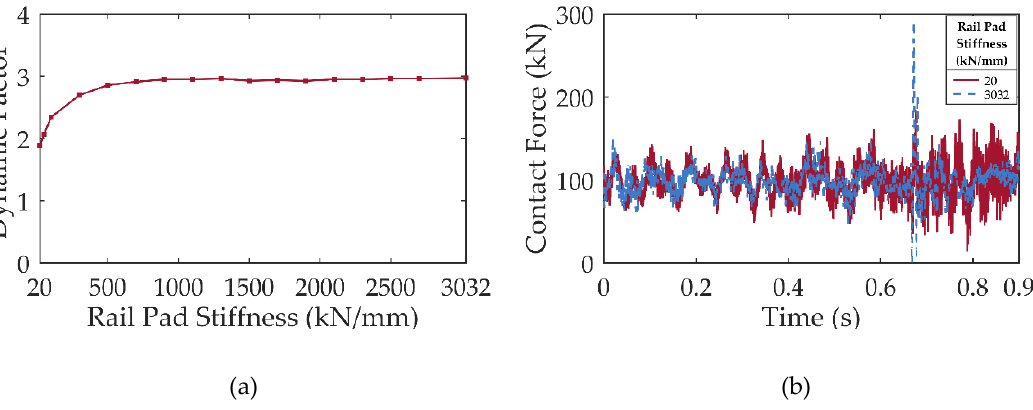
Figure 9. Dynamic e ff ects: ( a ) Variations in dynamic factor which correspond to rail pad sti ff ness; Figure 9. Dynamic effects: ( a ) Variations in dynamic factor which correspond to rail pad stiffness; ( b ) ( b ) contact forces for minimum and maximum rail pad sti ff contact forces for minimum and maximum rail pad stiffness.